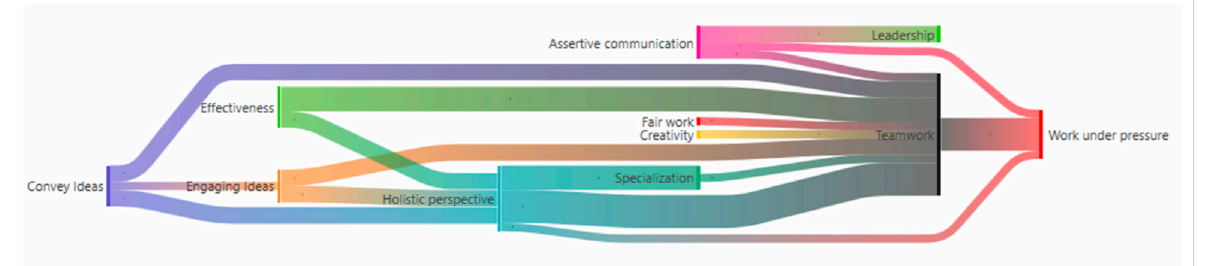
Figure 2. Sankey diagram for emerging